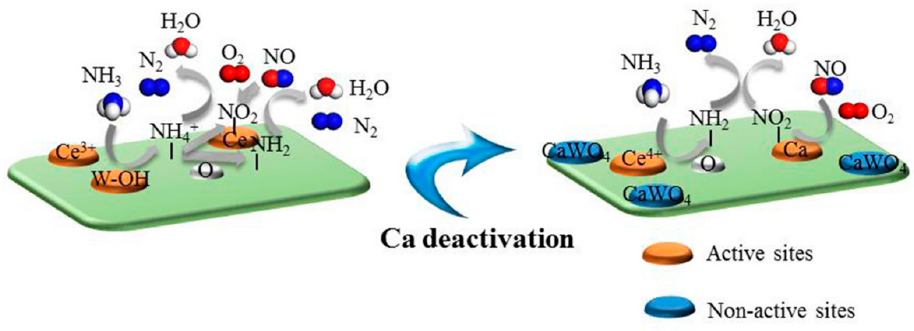
Figure 10. Schematic of calcium poisoning mechanism on CeO 2 -WO 3 catalyst [58].